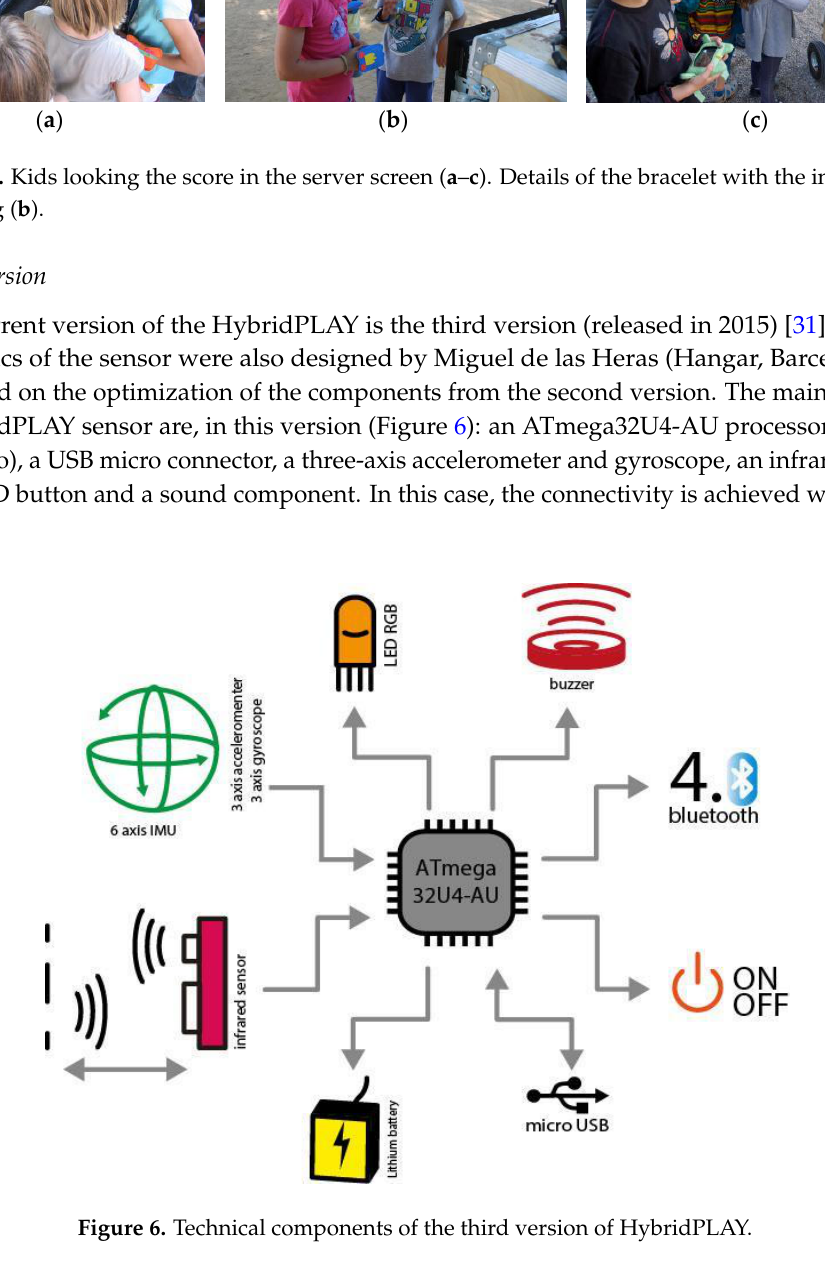
such a way that he/she could see the screen at all times to provide precise instructions to the other